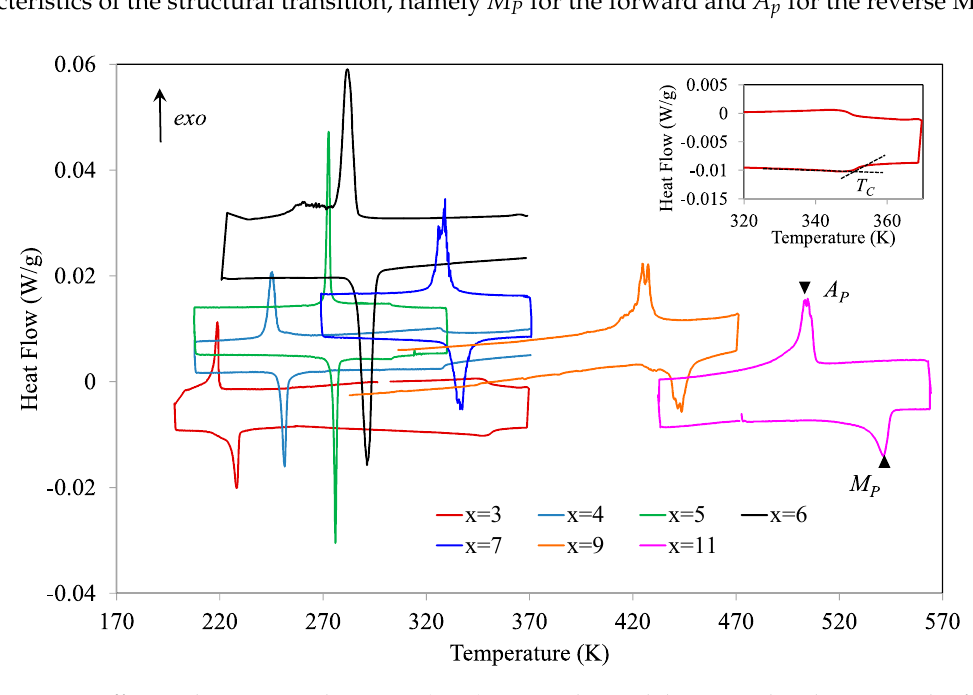
Figure 1. Di ff erential scanning calorimetry (DSC) curves obtained during cooling / heating cycles for the complete set of studied alloys. The characteristic temperatures, M P for the forward and A p for the reverse martensitic transformations (MTs), are also indicated. The inset shows the determination of the Curie temperature of austenite, T CA , for the alloy with x = 3.